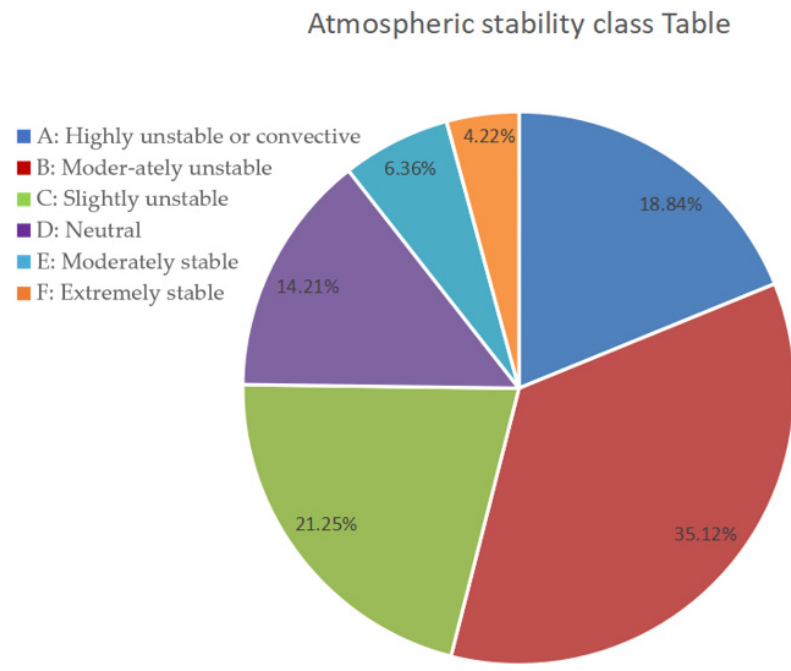
Figure 8. Resource diagram for position of Yangkou wind farm.